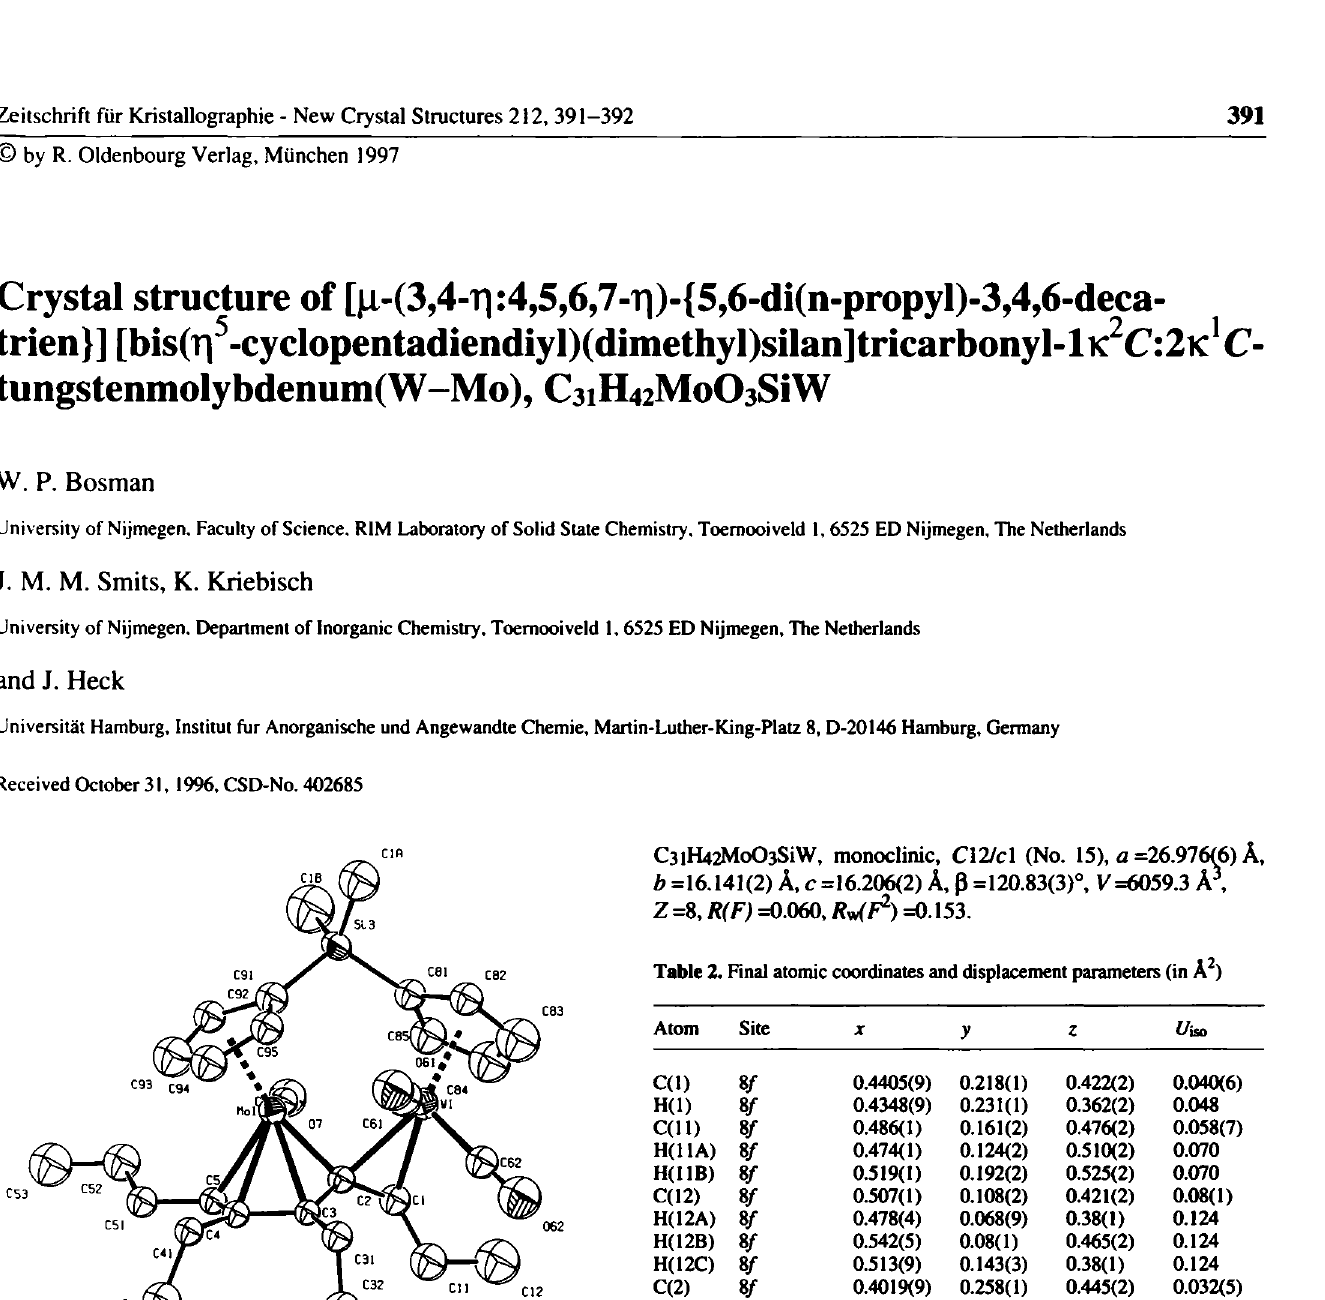
Table 2. Final atomic coordinates and displacement parameters (in A 2